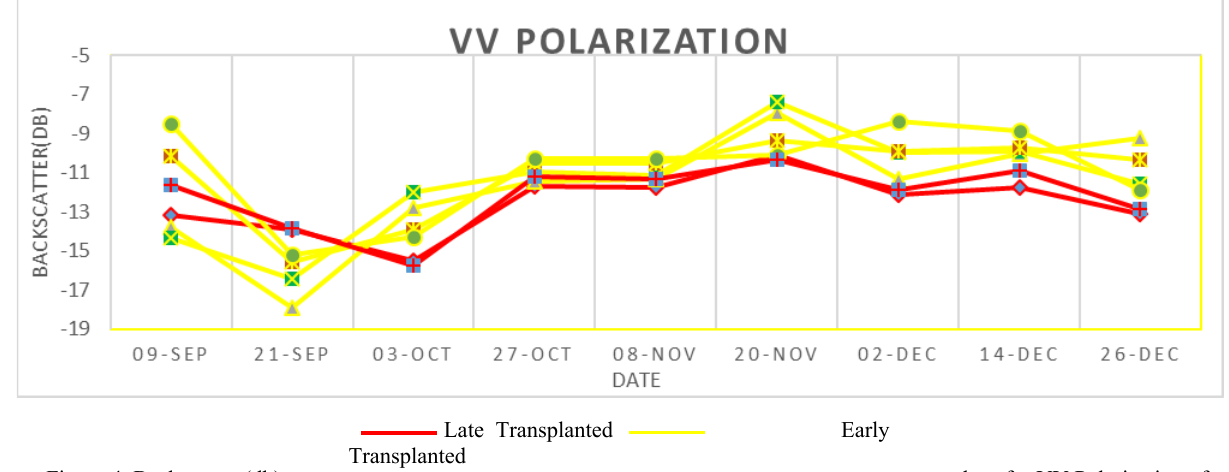
Figure 4. Backscatter (db) values for VV Polarization of Rice